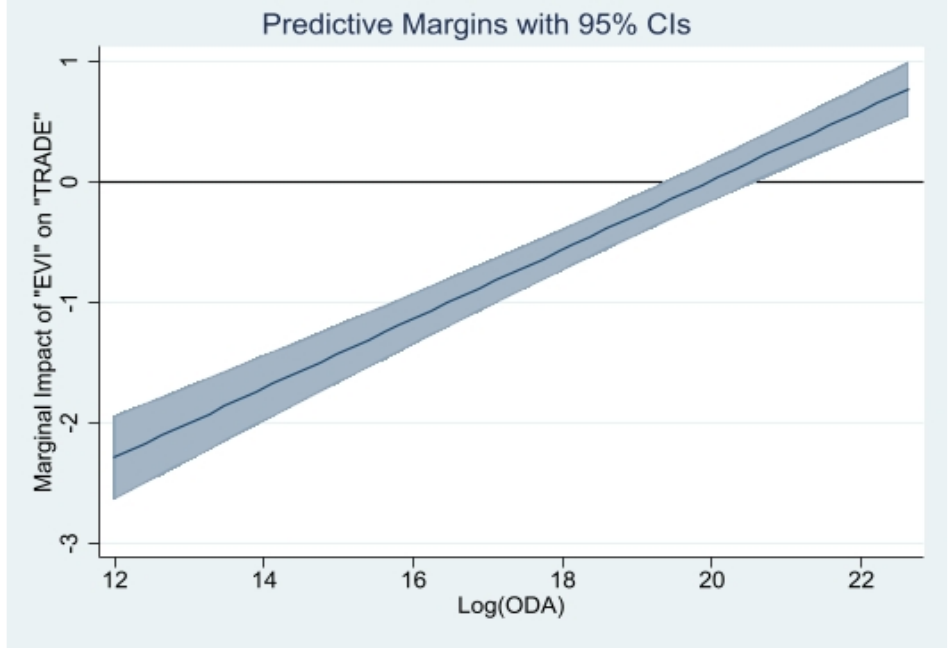
Figure 12. Marginal impact of “EVI” on “TRADE” for varying amounts of development aid. Source: Author.